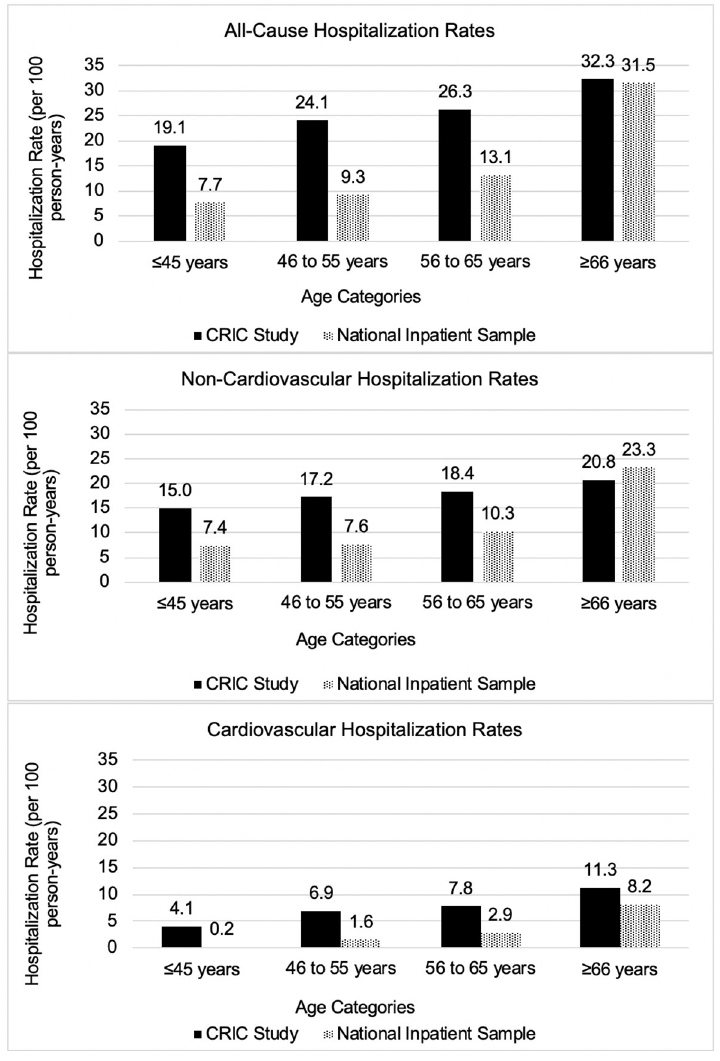
Fig 5. Hospitalization rates (per 100 person-years) across age categories in the CRIC Study and national inpatient sample. CRIC, Chronic Renal Insufficiency Cohort.